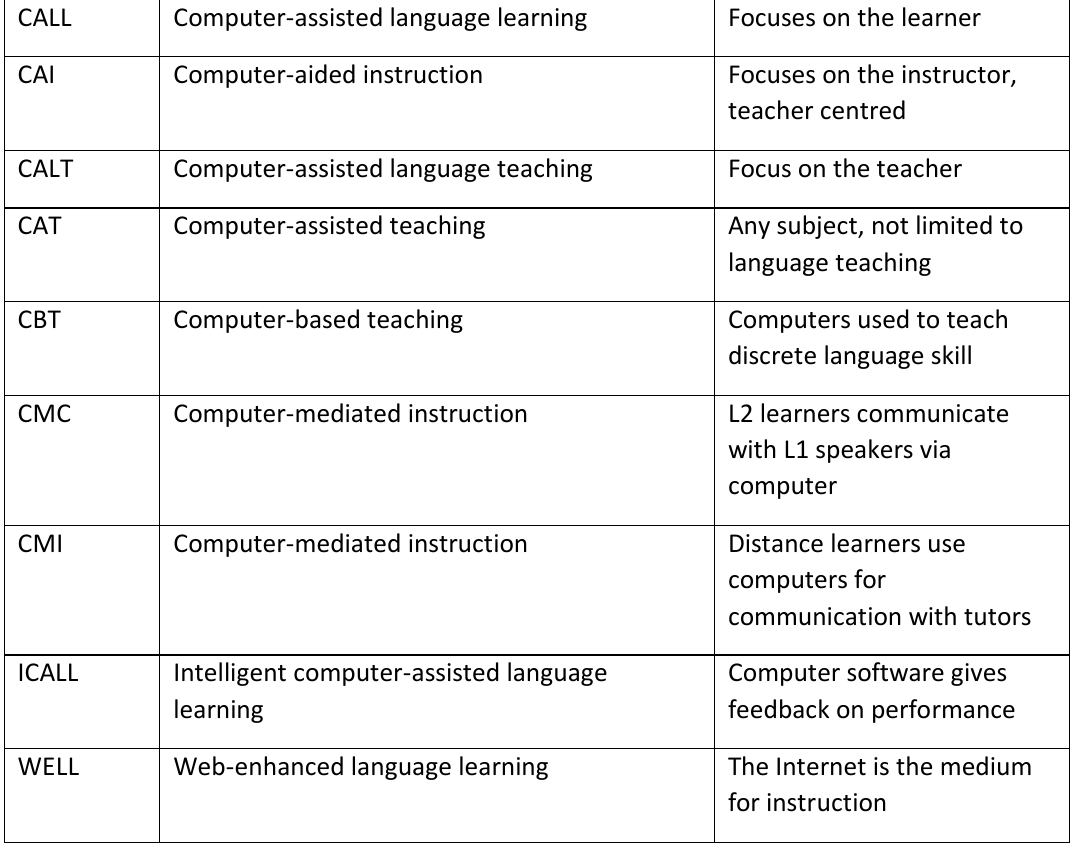
Table 1: CALL and related